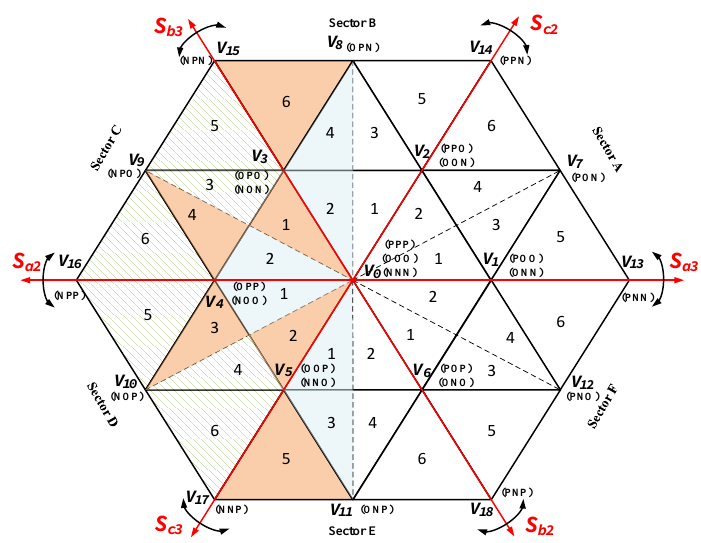
Figure 11. Regions of the proposed three tolerant control method cases on the space vector diagram.